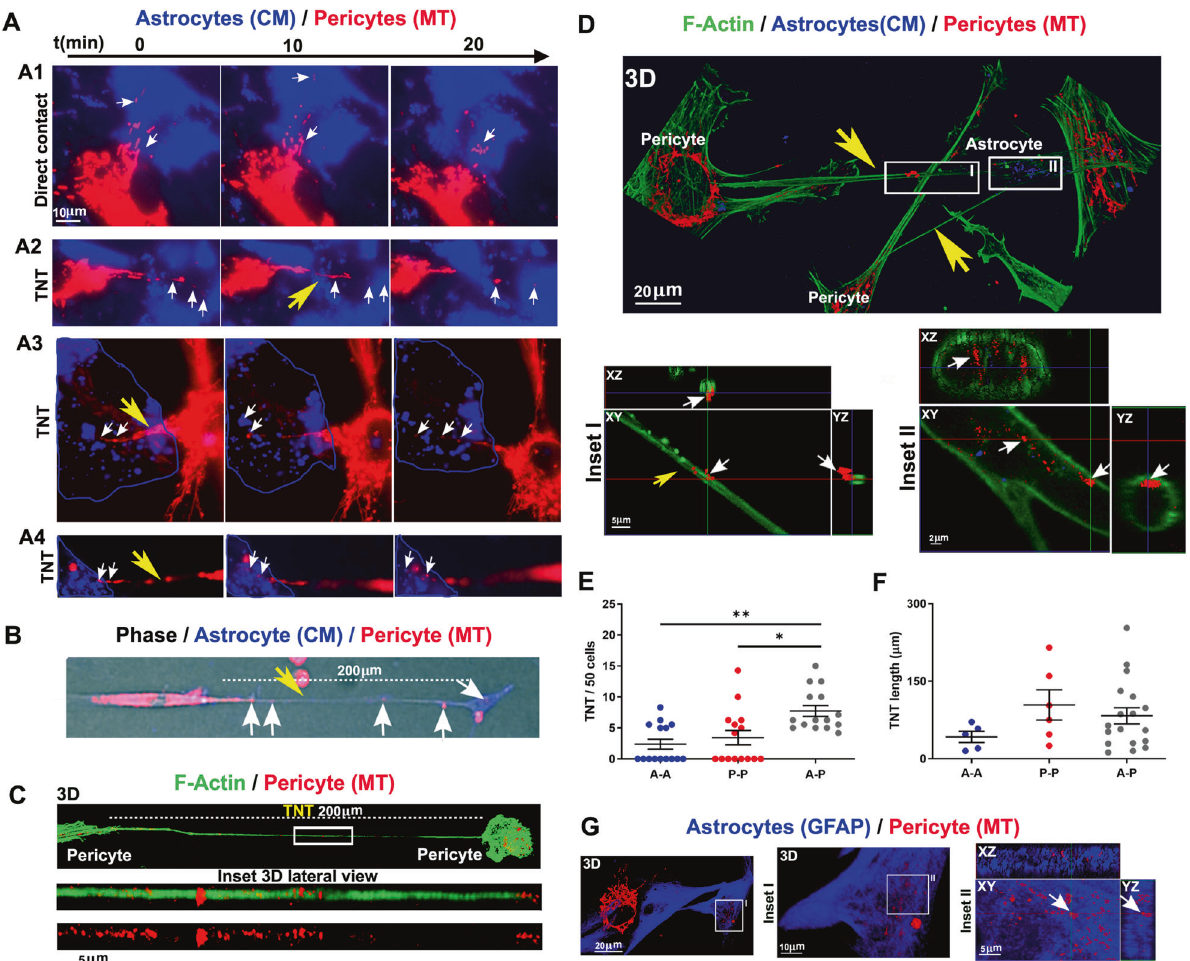
Fig. 1 Pericytes transfer functional mitochondria to astrocytes via TNT. Functional mitochondria of pericytes were stained with ΔΨ - dependent MitoTracker Deep Red (MT; red), while the plasma membrane of astrocytes was stained with CellMask Orange (CM; blue). Cells were co-cultured and analyzed for intercellular traf fi cking of mitochondria by time-lapse and confocal fl uorescence microscopy. A Live time- lapse analysis of mitochondria traf fi cking. Immediately after seeding, MT-labeled mitochondria (red) from pericytes are actively transferred to astrocytes at direct contacts (panel A1; Suppl. Movie 1). After 1 h (panel A2; Suppl. Movie 2) and up to 24 h (panels A3, A4; Suppl. Movies 3 – 7), long plasma membrane intercellular bridges, a.k.a. TNT, are formed through which mitochondria are transferred from pericytes to astrocytes. After a few hours, the plasma membrane marker of astrocytes undergoes internalization in the form of intracellular vesicles (blue) due to the ongoing membrane turnover. Yellow arrows, TNT; white arrows, mitochondria. Representative images from N = 7 independent preparations, with > 10 sampled areas per experiment. B Wide fi eld imaging of a long pericyte-astrocyte TNT. TNT (200 μ m in length; yellow arrow) between a pericyte (red, left) and an astrocyte (blue, right) acquired by live wide fi eld fl uorescence microscopy. Note the presence of pericyte mitochondria (white arrows) inside the TNT. C Confocal imaging of pericyte-pericyte TNT. After 24 h of co-culture, cells were fi xed and stained for F-actin using fl uorescent phalloidin (green). 3D reconstruction of a long (> 200 μ m) pericyte-pericyte TNT in which many mitochondria are visible. D 3D reconstruction of a long pericyte-astrocyte TNT. The long TNT stained for F-actin using fl uorescent phalloidin (green) is detached from the glass surface and connects to an astrocyte along which mitochondria from the pericyte are visible (inset I; red). The lower inset (inset II) shows an intracellular XY plane of the CM-labeled astrocyte (blue intracellular vesicles) in which many mitochondria of pericyte origin are visible (red). Representative images from N = 3 independent experiments with > 10 sampled areas per experiment. E Quanti fi cation of homotypic-TNT (A-A or P-P) and heterotypic-TNT (A-P) number after 24 h of co-culture. A single dot represents the TNT number/ fi eld of 50 cells. N = 3 independent experiments with > 10 sampled areas per experiment. F Quanti fi cation of homotypic-TNT and heterotypic-TNT length after 24 h of co-culture. N = 3 independent experiments with > 10 sampled areas per experiment. G GFAP immuno fl uorescence analysis. 3D reconstruction, XY plane, and Z-projections by confocal microscopy show pericyte mitochondria inside GFAP-positive astrocytes. Representative images from N = 3 independent experiments with > 10 sampled areas per experiment. In E , F : N = 3 independent experiments with > 10 sampled areas per experiment. * p < 0.05, ** p < 0.005; Kruskal – Wallis/Dunn ’ s